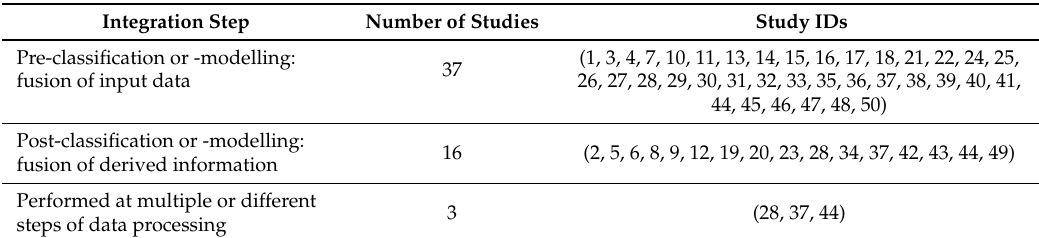
Table 7. Summary of the analysis step at which data fusion is performed in land use-related studies. Integration